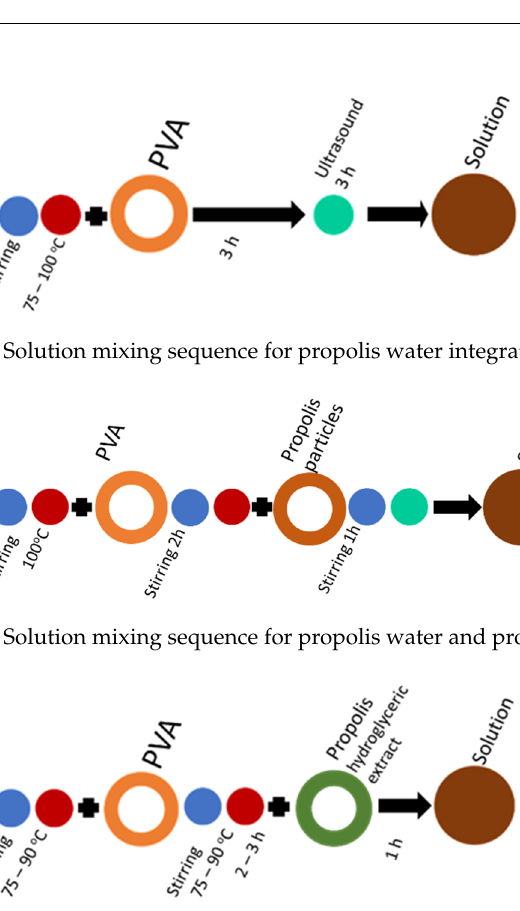
Figure 8. Solution mixing sequence for propolis water and propolis hydroglyceric extract integration.